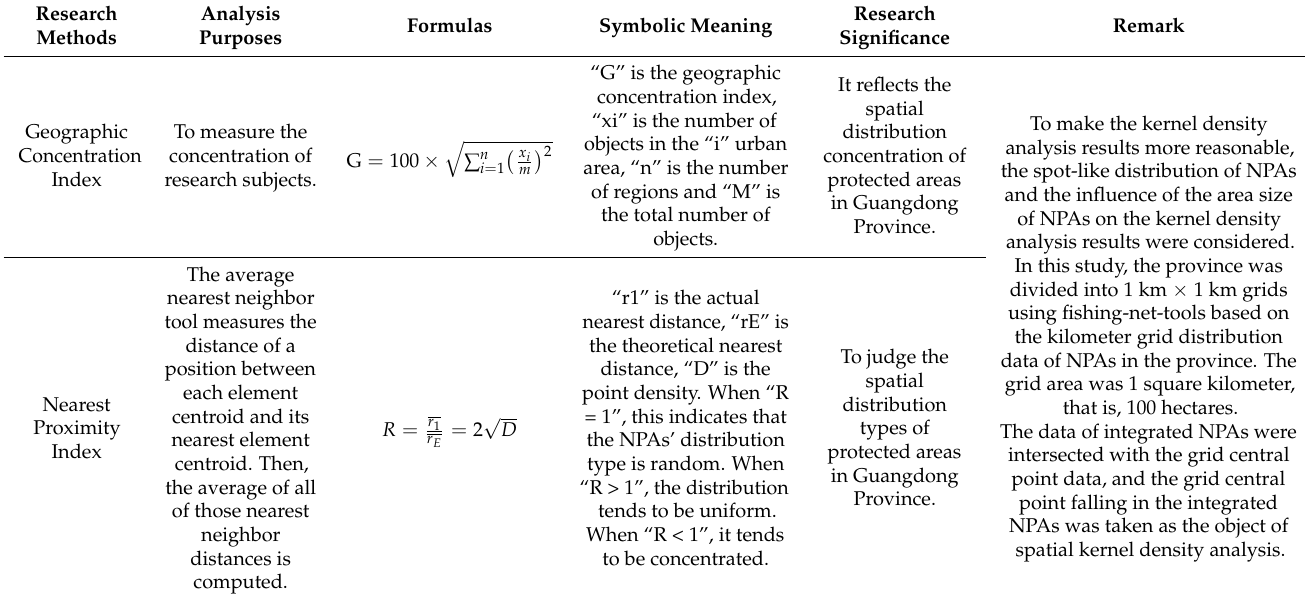
Table 1. Analytical methods and main